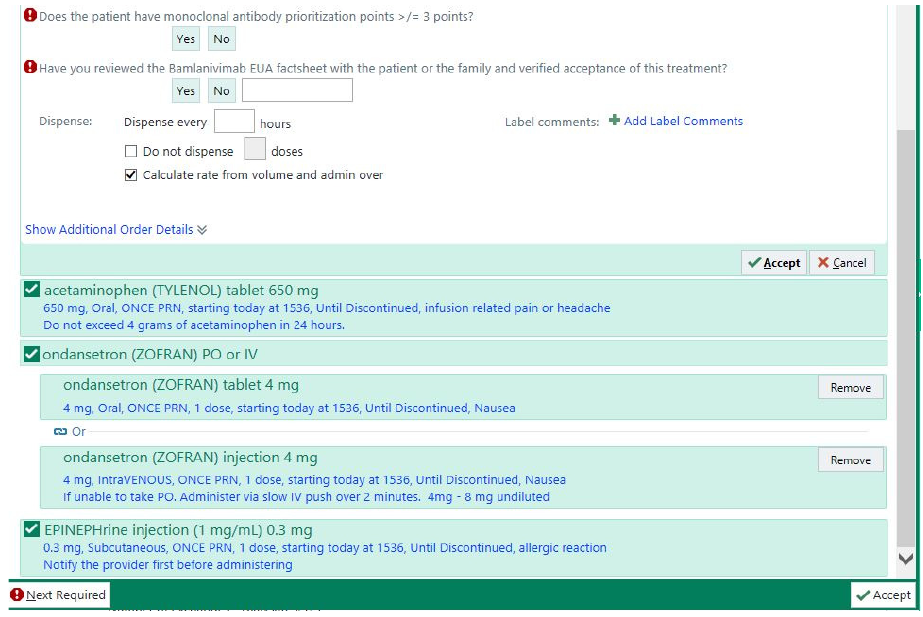
Figure 2. Bamlanivimab order set. The bamlanivimab order set contained two required questions that the pharmacist had to answer, as well as supportive medications in case they were needed.